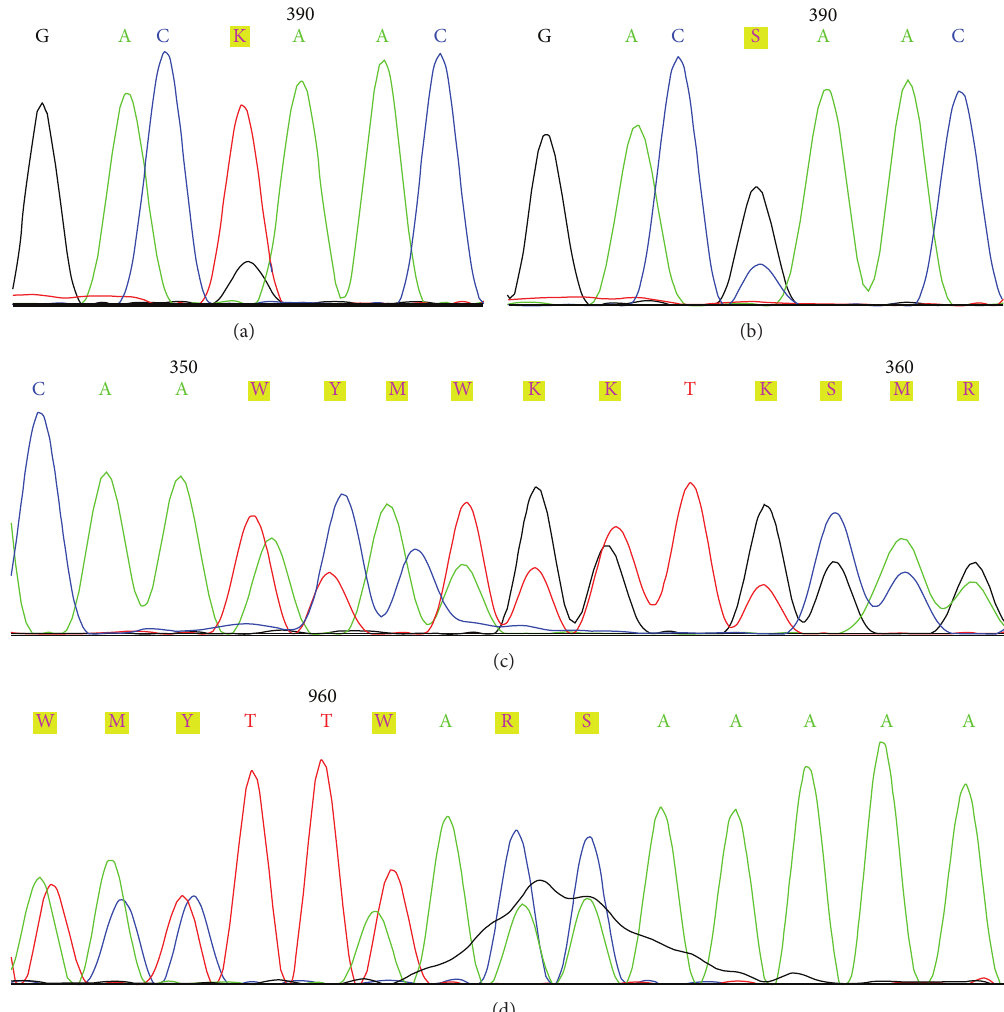
Figure 2: DNA sequencing histograms from three patients with the most frequent mutations of the PTEN gene. (a) Substitution in codon 130, G > T, forward primer used; (b) Substitution in codon 130, G > C, forward primer used; (c) A insertion in codon 117, forward primer used; (d) A deletion in codon 323, reverse primer